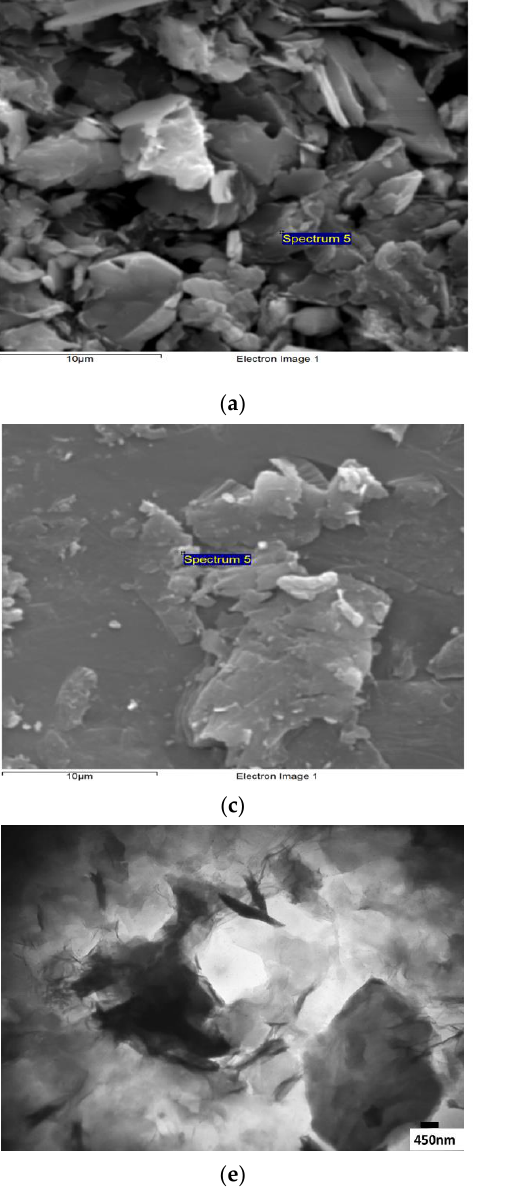
Figure 5. ( a ) SEM image of GO; ( b ) EDX of GO; ( c ) SEM image of GO-COOH; ( d ) EDX of GO-COOH ( e ) TEM micrograph of GO; ( f ) TEM micrograph of GO-COOH.